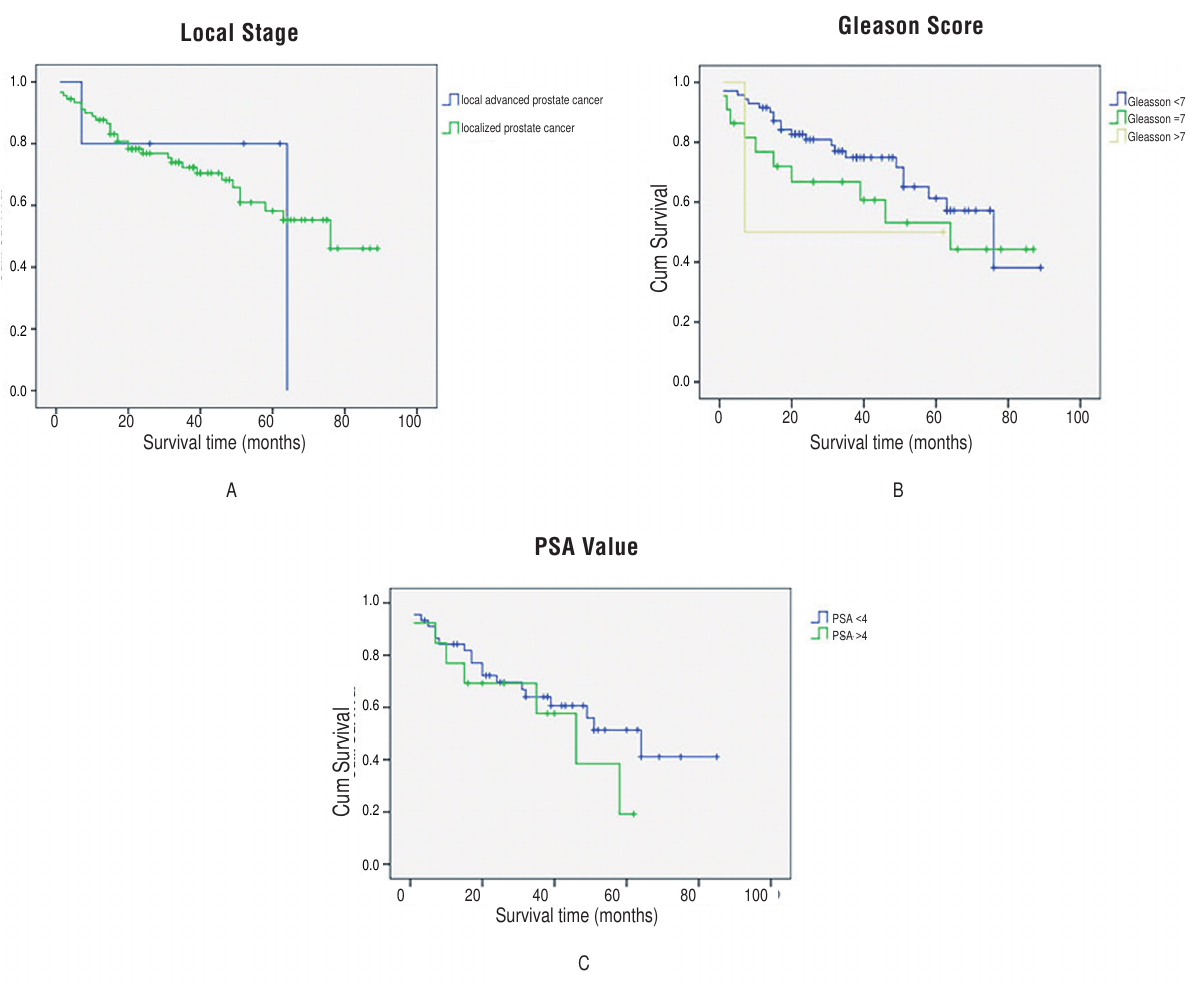
Figure 4 - Estimated Kaplan-Meier overall survival curves for patients with prostate cancer stratified by stage of prostate cancer ( P= 0.966) (a) Gleason score ( P= 0.504) (b) and PSA value ( P= 0.354)